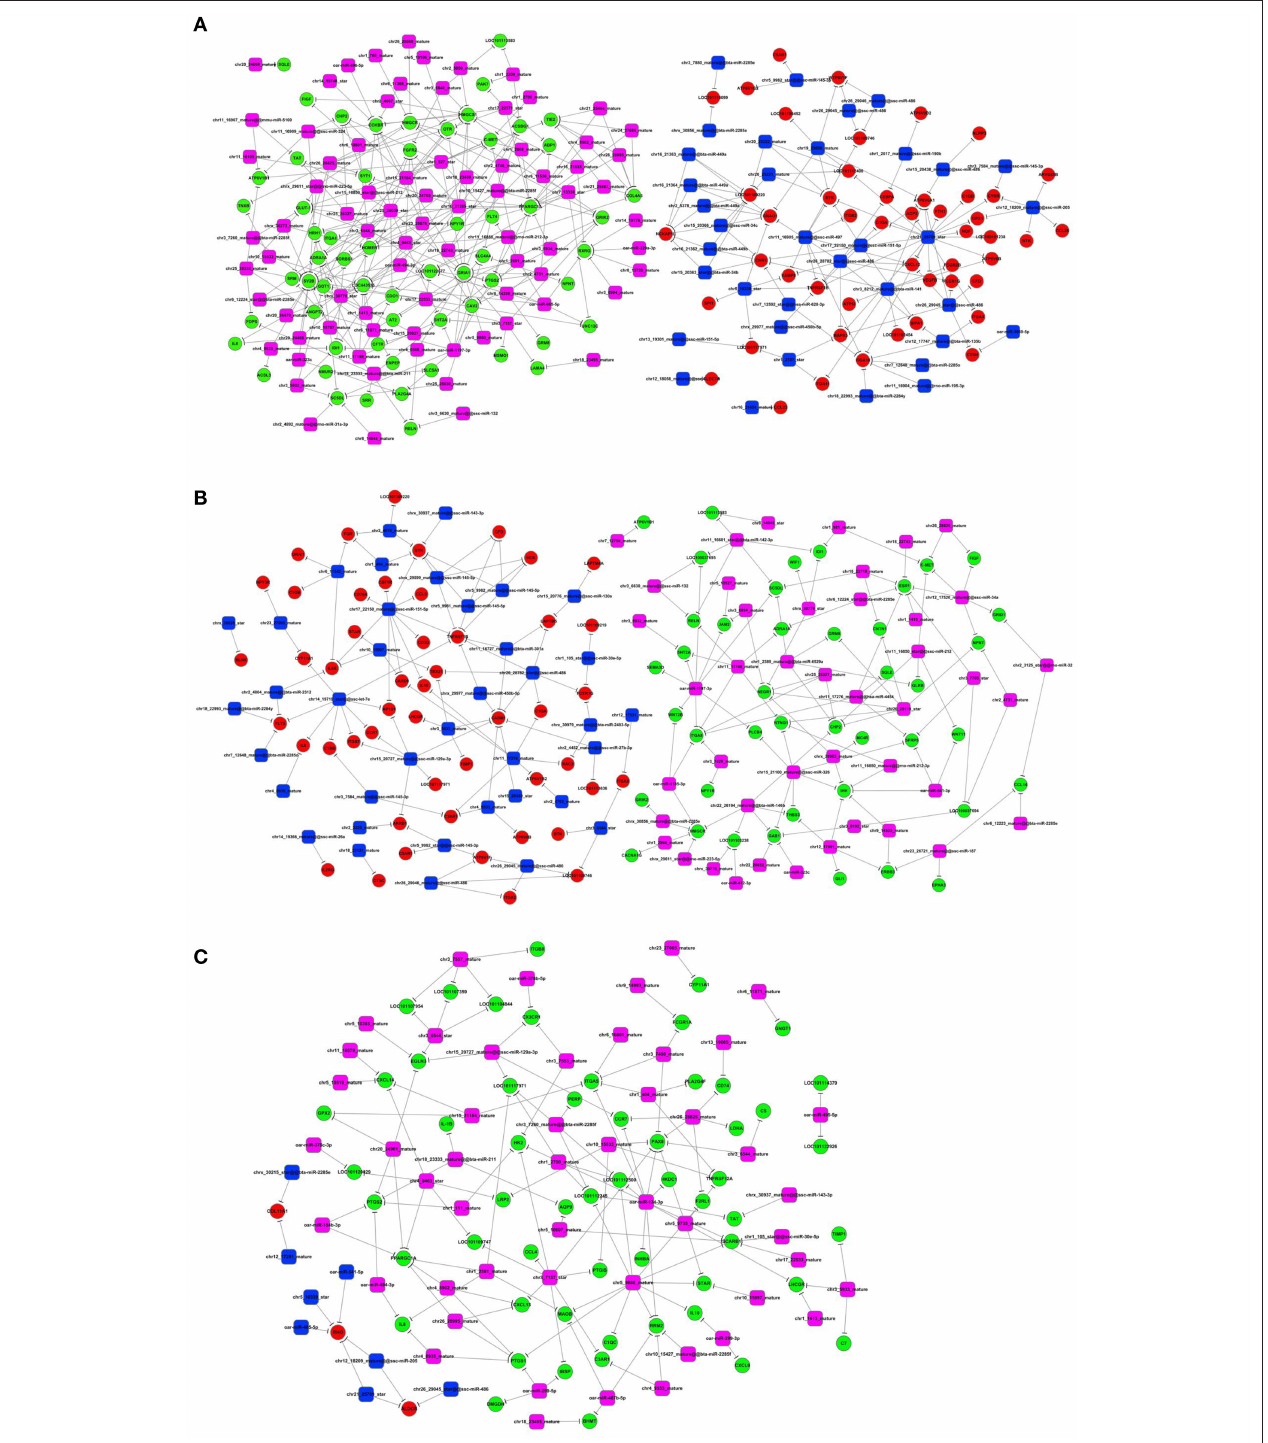
FIGURE 2 | Integrative analysis of the differentially expressed genes and the miRNAs. (A–C) Construction of miRNA-mRNA regulatory networks for the different groups. Green indicates the down-regulated mRNA, and red indicates the up-regulated mRNA. Blue indicates the down-regulated miRNA, and purple indicates the up-regulated